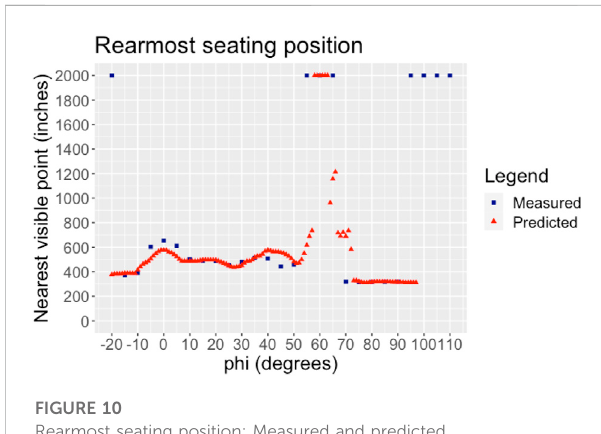
FIGURE 10 Rearmost seating position: Measured and